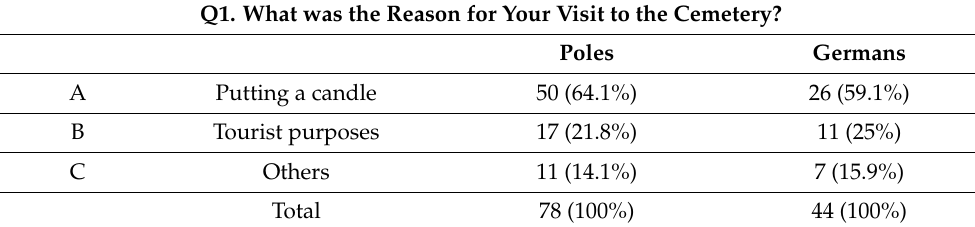
Table 2. Reasons for visiting the studied cemeteries in Poland and